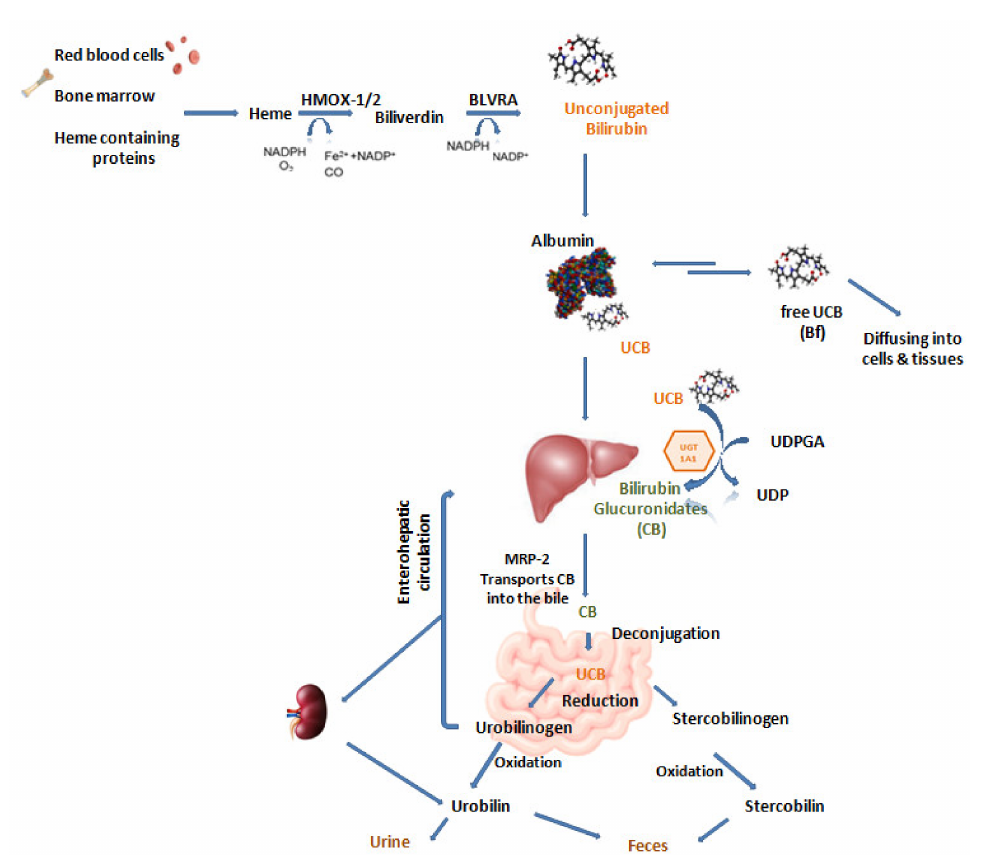
Figure 1. Bilirubin metabolism. HMOX-1/2: hemeoxygenase enzyme; NADPH: nicotinamide adenine dinucleotide phosphate reduced form; O 2 : oxygen; Fe 2+ : ferrous ions; NADP + : nicotinamide adenine dinucleotide phosphate oxidized form; CO: carbon monoxide; BLVRA: biliverdin reductase A enzyme; UCB: unconjugated bilirubin; Bf: free bilirubin; UGT1A1: uridine diphosphate-glucuronosyl transferase 1A1; UDPGA: uridine 5 (cid:48) -diphosphoglucuronic acid; UDP: uridine diphosphate; CB: conjugated bilirubin;MRP-2:multidrug resistance-associated protein